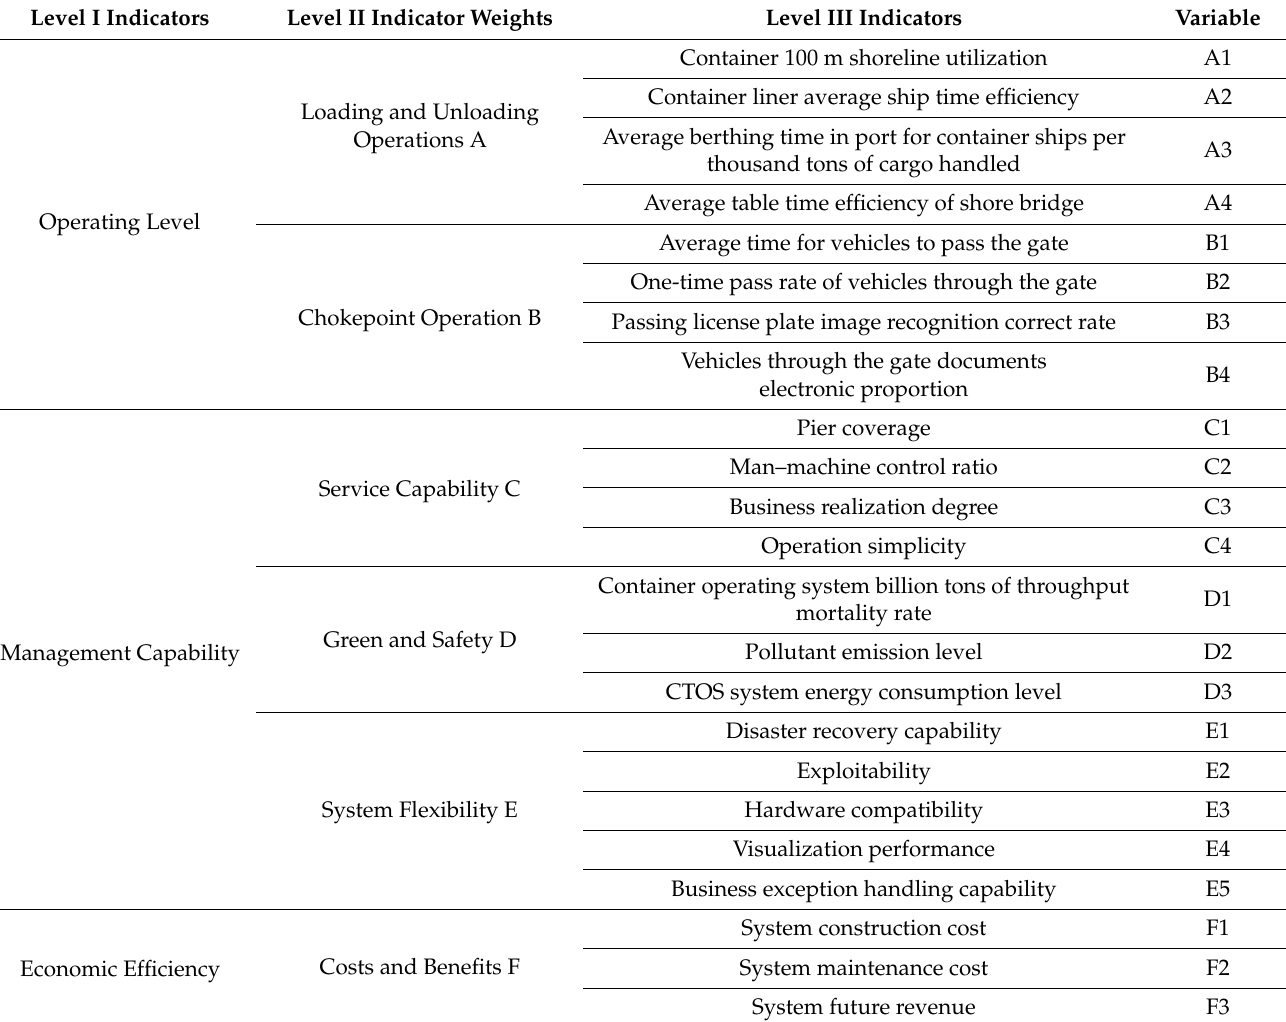
Table 1. Table 1. Evaluation index system of